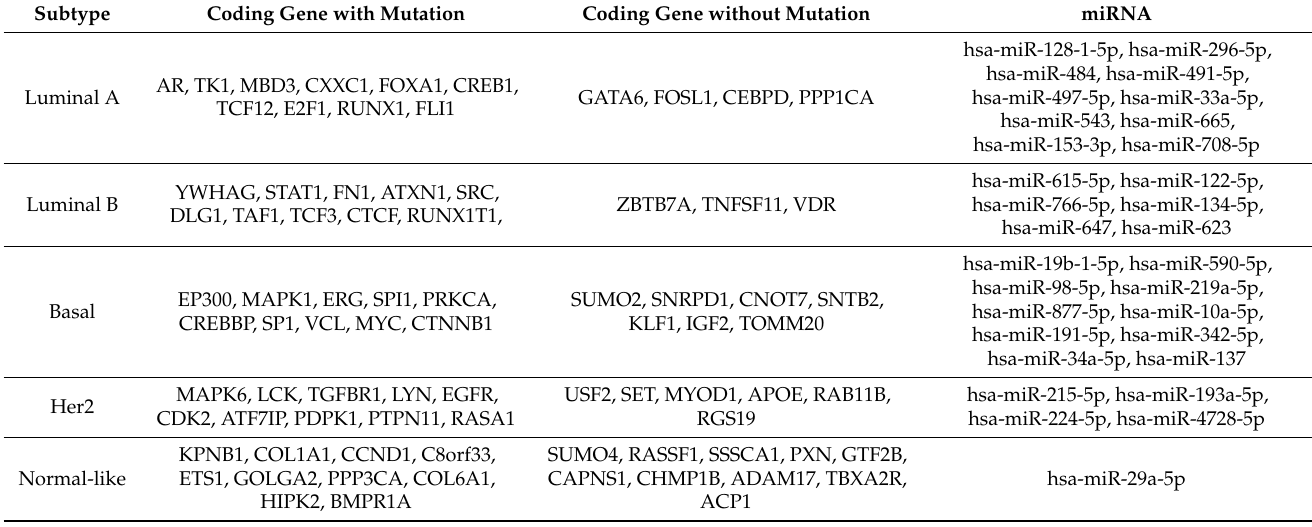
Table A3. Lists of drivers for breast cancer